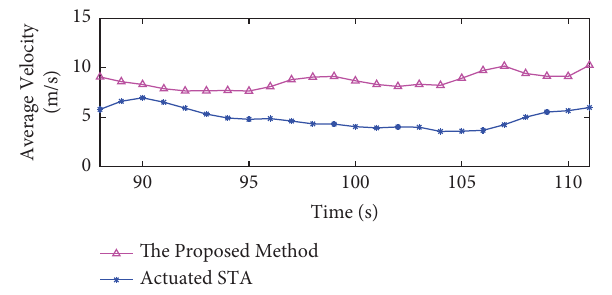
Figure 9: Test results of average velocity with two